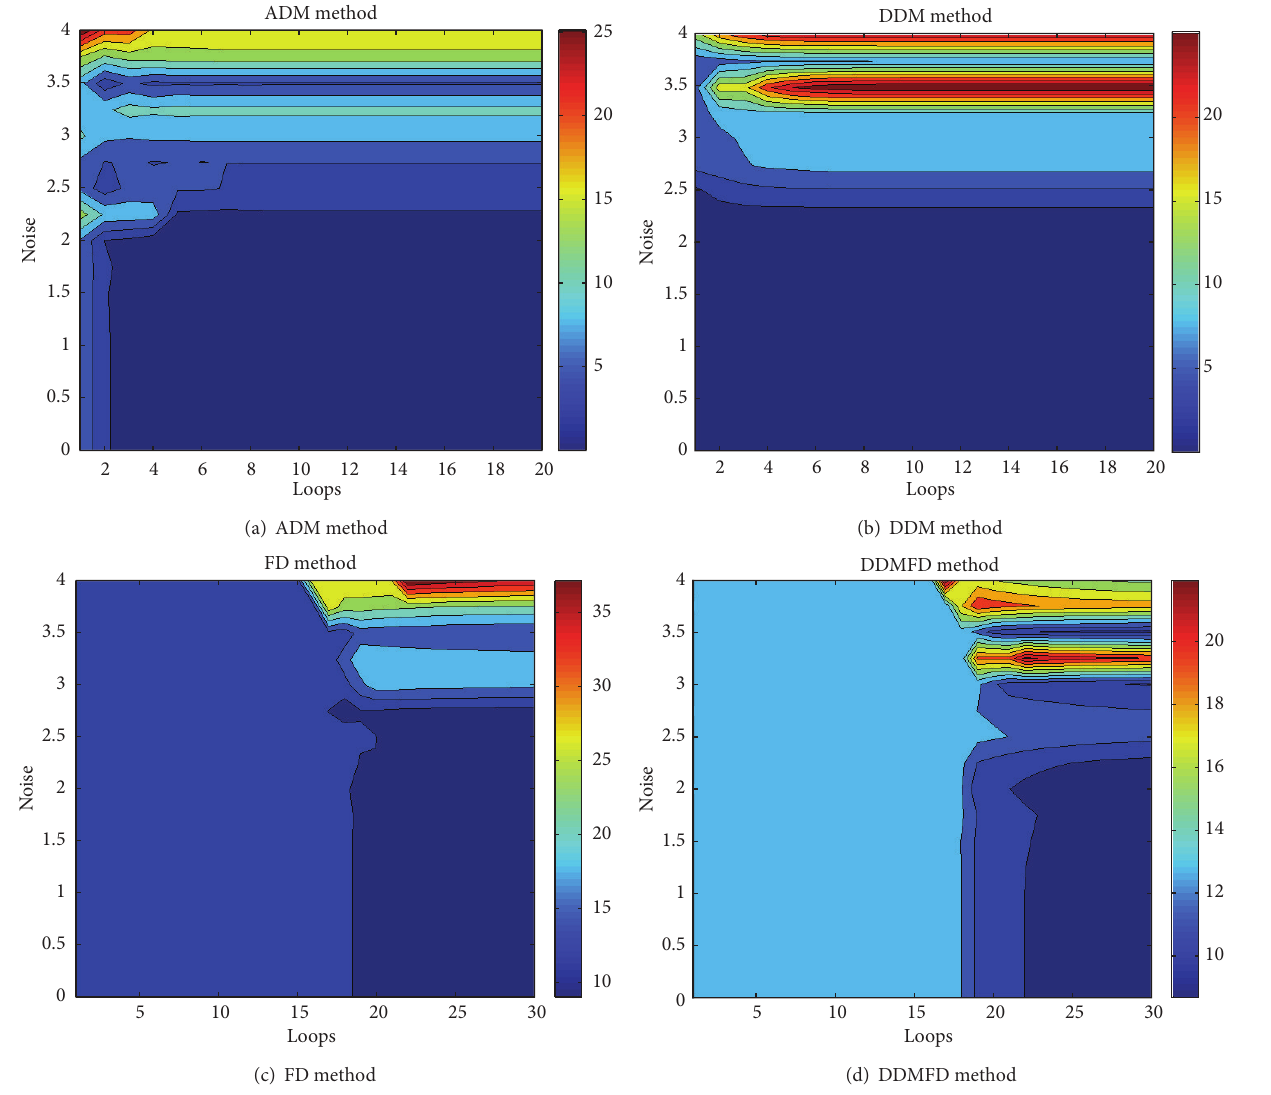
Figure 3: RPE contours with respect to noise level and loops in model